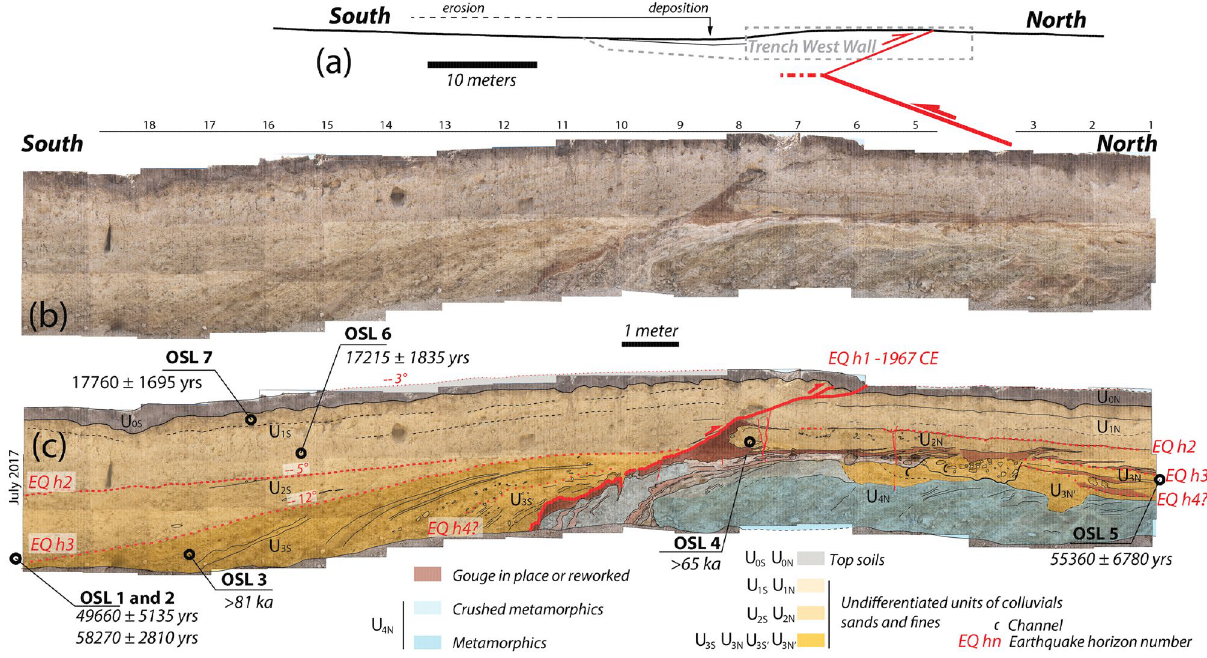
Figure 3. West Wall of the trench ( a ) Profile through the topography of Fig. 2 and emplacement of the trench wall. ( b ) Photomosaic and ( c ) Log of the west wall of the trench. July 2017. Minimum age Model OSL age from Table 1 are reported. Grey units U0 correspond to the topsoil offset by the 1967 surface rupture. It is deposited above U1 and U2 that correspond to undifferentiated units of sands and fines separated by an earthquake horizon (EQh2). This horizon corresponds to an erosional surface in the part located south of the backthrust and to a reworked red gouge in the northern part. EQh3 similarly separates U3 from U2. U3 sedimentary units were deposited above the metamorphic rocks of U4 (in